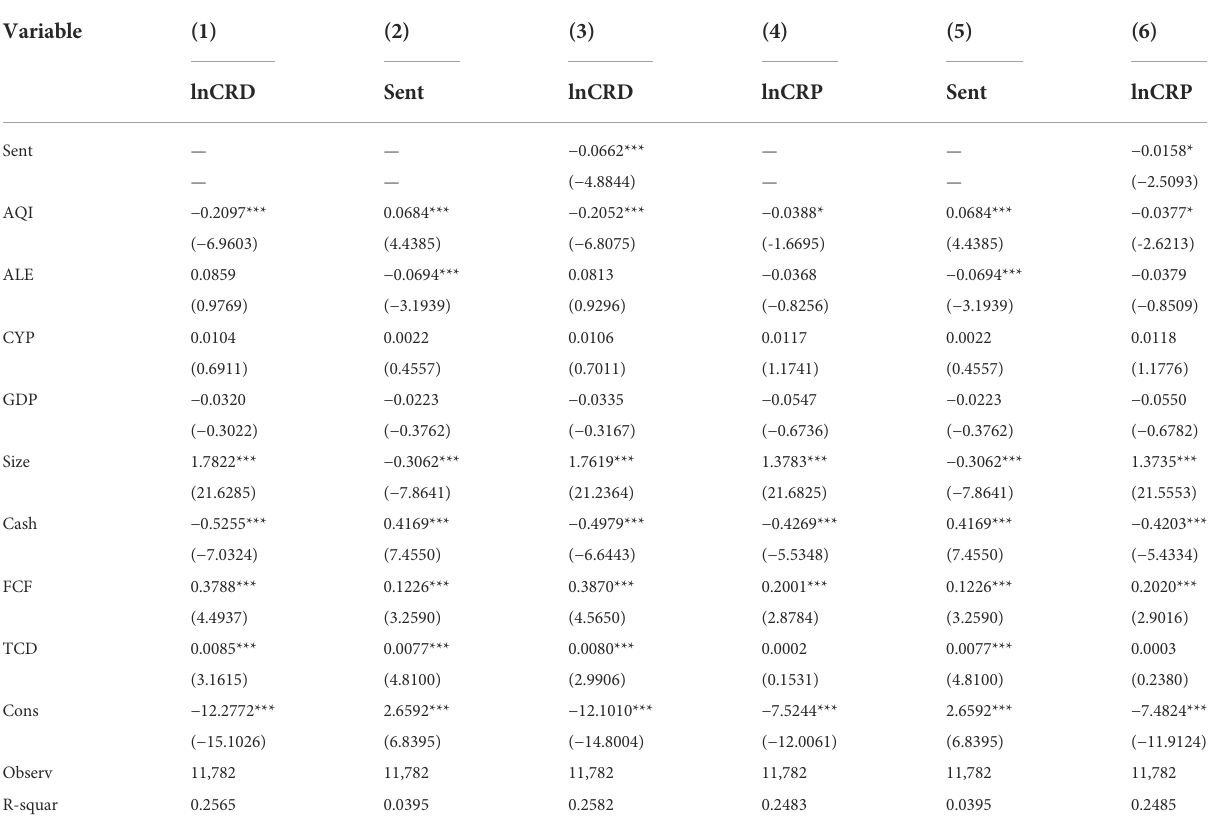
TABLE 4 Benchmark regression of the intermediary effect of investor sentiment. Variable